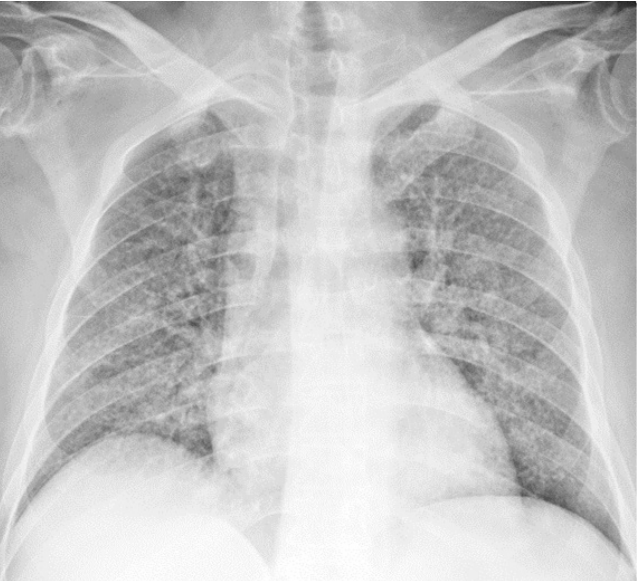
Figure 2. Chest X-ray showing bilateral lung interstitial thickening; the cardiac shadow is within normal limits; clear costophrenic angles.